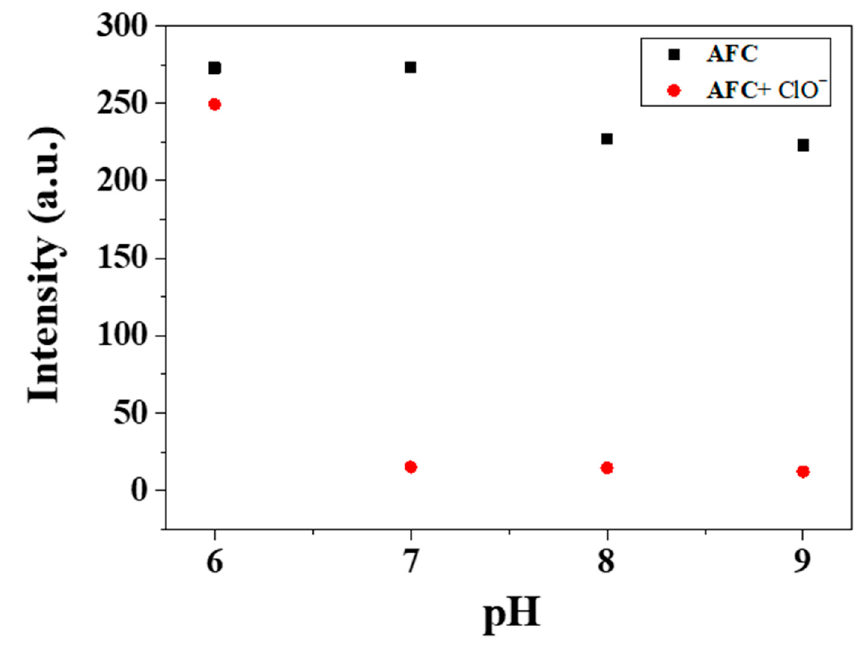
Figure 6. Fluorescence emission (at 455 nm) of AFC with ClO − at pH 6–9.